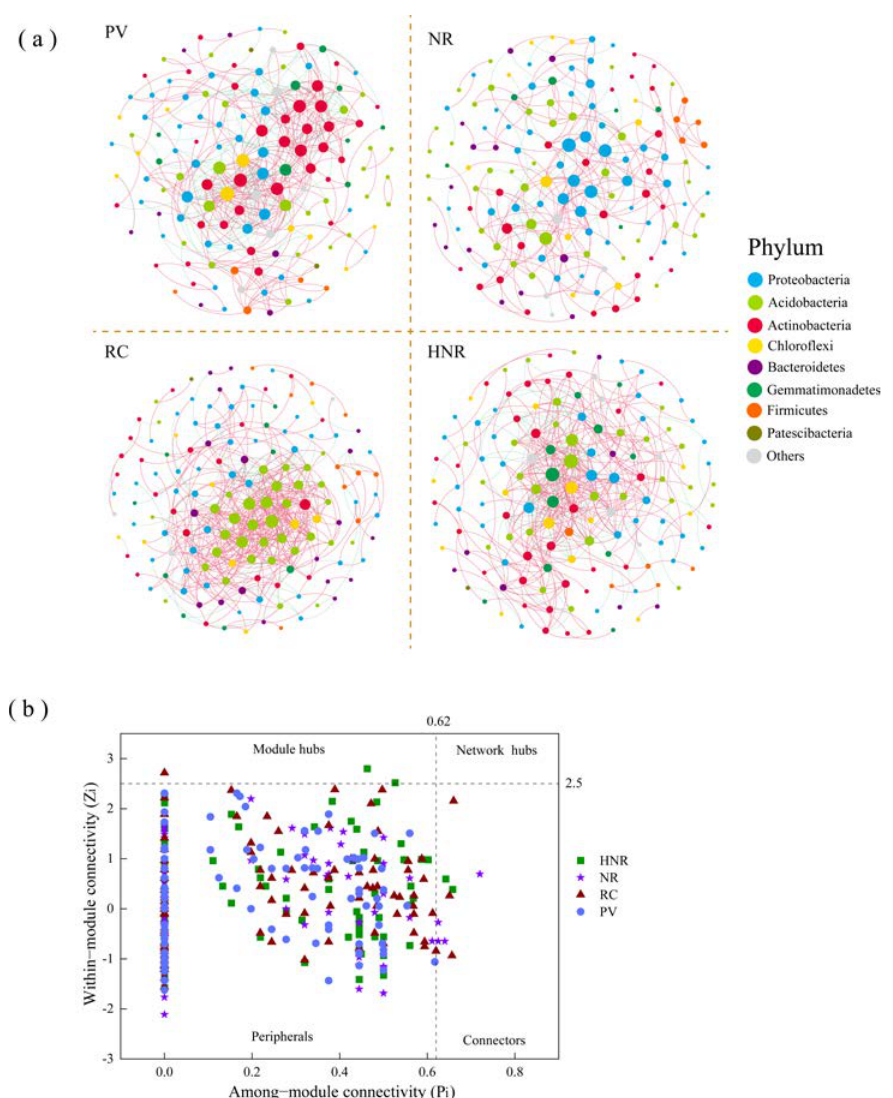
Figure 9. Microbial molecular ecological networks ( a ) and a Z − P plot ( b ) at the phylum level in the study area.